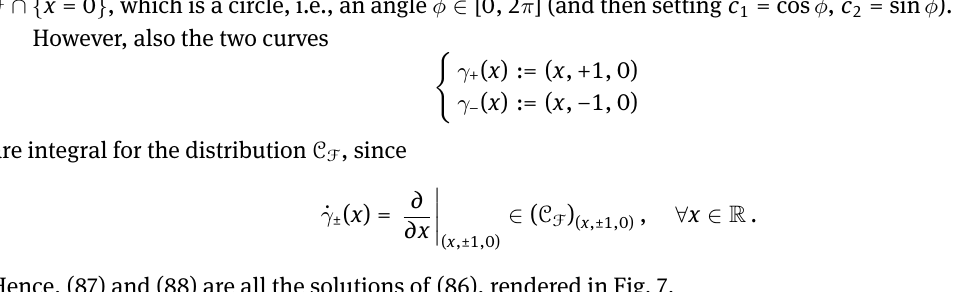
Fig. 7. Two solutions of ( u ′ ) 2 + u 2 = 1 artistically rendered to show the difference between the regular and singular ones. Regularandsingularsolutionstotheequation( u ′ ( x )) 2 +( u ( x )) 2 =1.